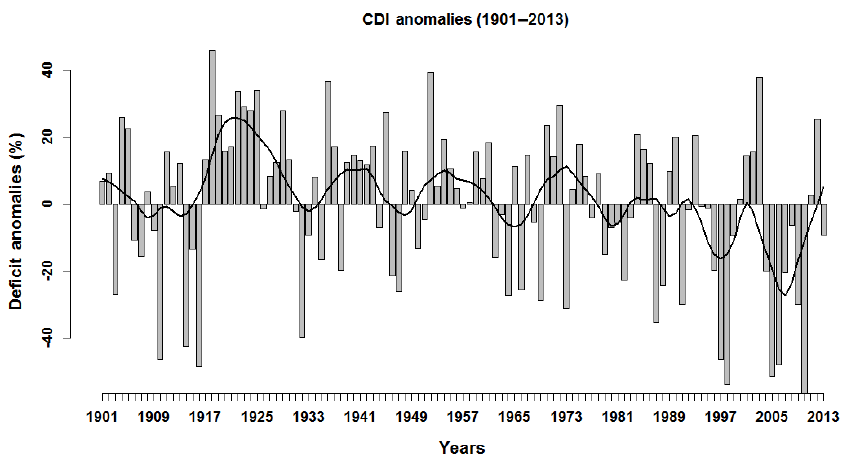
Figure 3. Bar plot showing the CDI percent deficit anomalies for each of the years/growing seasons under consideration (1901–2013). The black, smooth time series is produced by an 11-year LOWESS smoothing of the CDI percent deficit anomalies and is meant to show the critical trends in the CDI over the entire 1901–2013